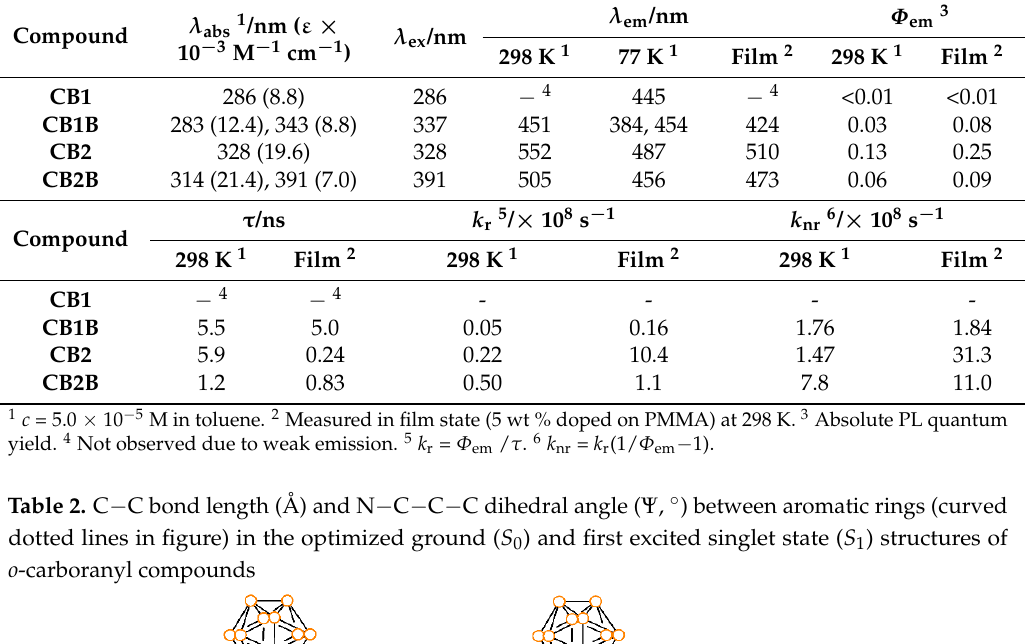
Table 1. Photophysical data of o -carboranyl compounds.